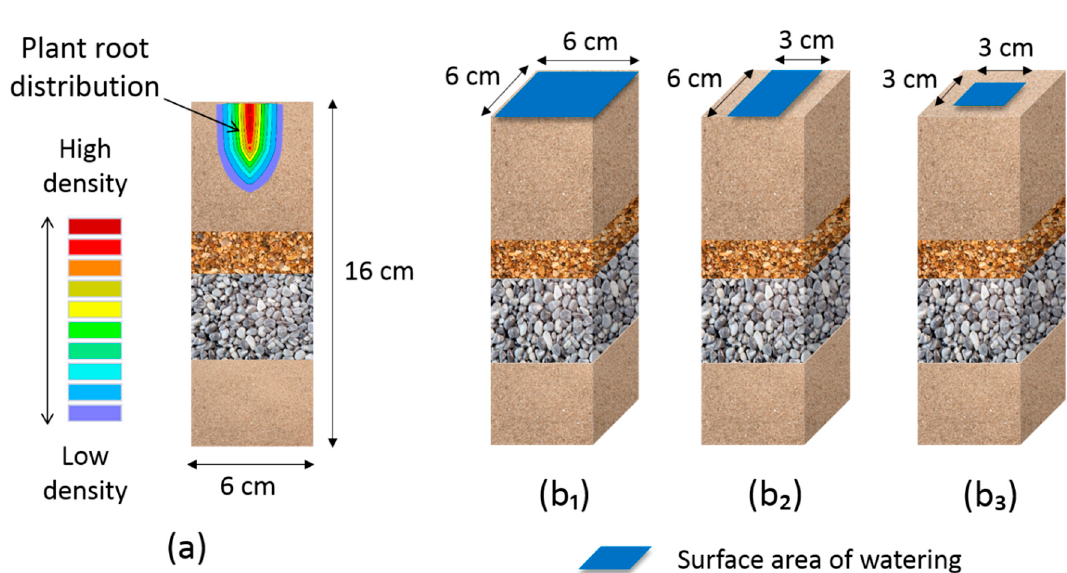
Figure 3. Schematic of root density distribution at the center cross-section of the simulation domain ( a ), and irrigation application types (uniform ( b 1 ), line-source ( b 2 ), and plant-targeted ( b 3 )).